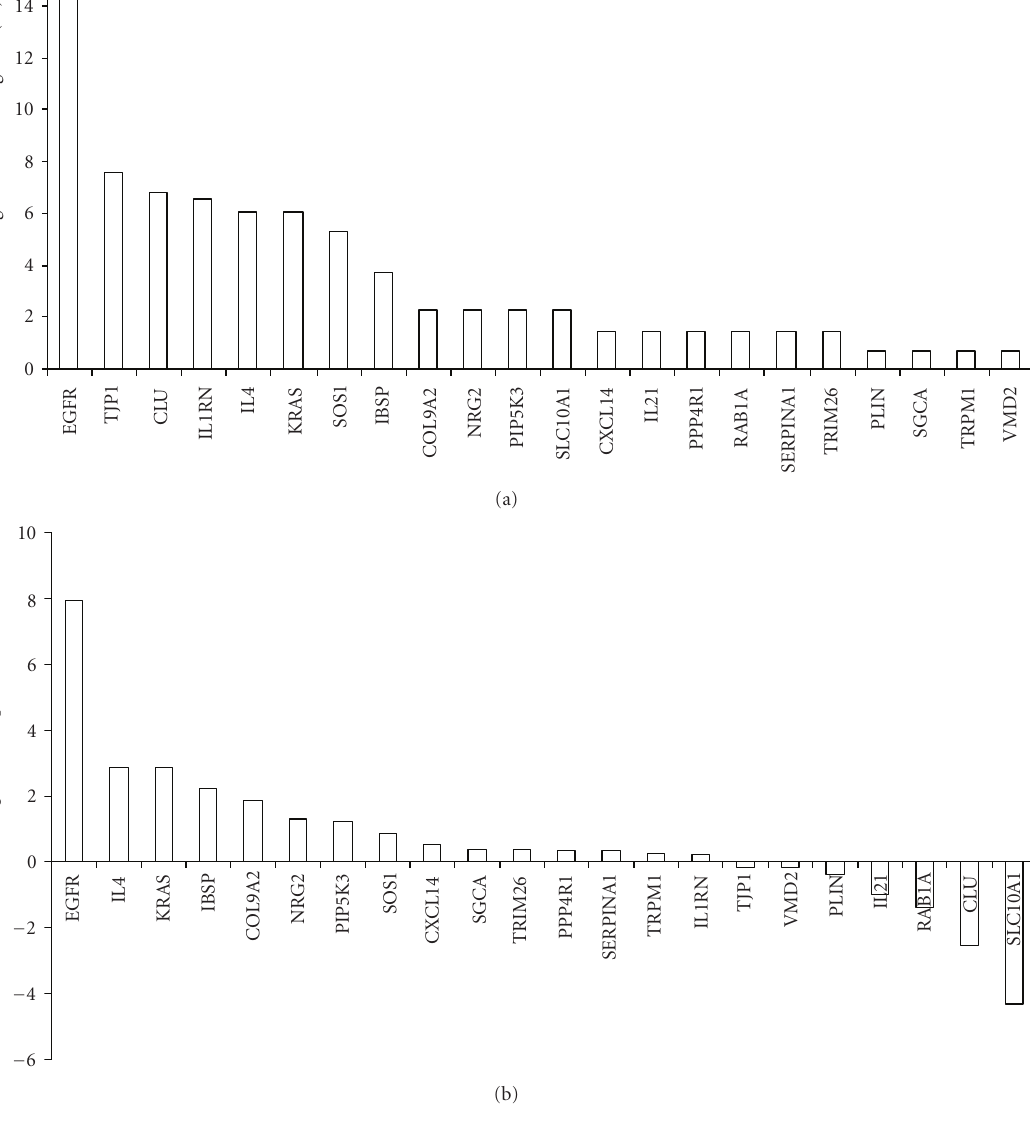
Figure 4: Contribution of individual genes to properties of the network enhanced by HCMV entry. Extracellular and membranecomponents of the network enhanced by HCMV entry (Figure 3) were individually knockedout in silico, and the e ff ects of such knock out were calculated. Only genes with at least two direct neighbors in the network were knocked out because genes with only one direct neighbor or without neighbors are located at the end-terminal in the network and would not significantly a ff ect the network architecture. (a) Contribution of individual genes to network connectivity. (b) Contribution of individual genes to network